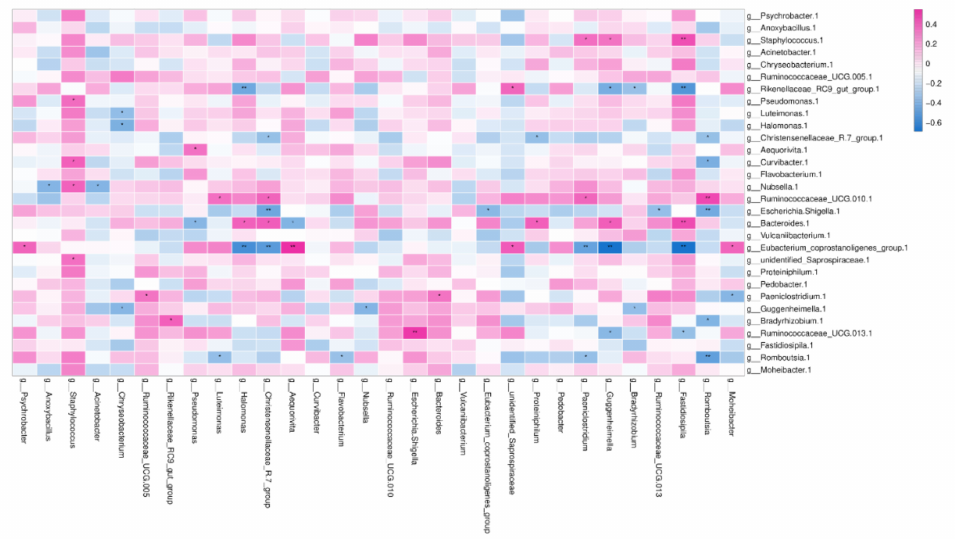
Figure 7. Spearman rank correlation between the relative abundances of the top 30 commonly shared bacterial genera in the colostrum and rectal feces. Note: The bacterial genera in milk and rectal feces were presented vertically and horizontally, respectively. g-genus; * p < 0.05; ** p <